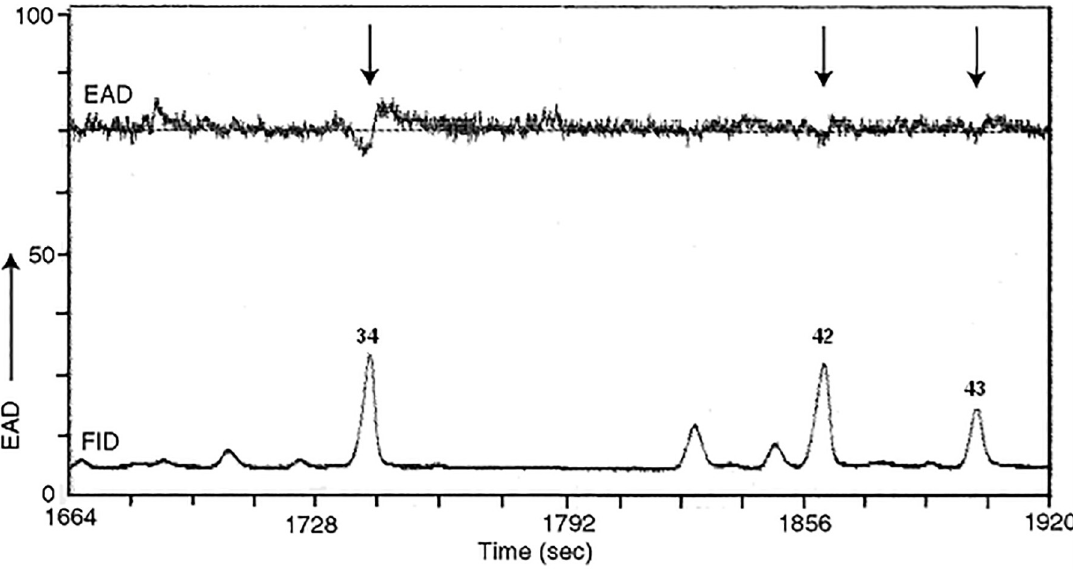
Fig 4. The EAD and FID signals for a section of the foot odor chemical